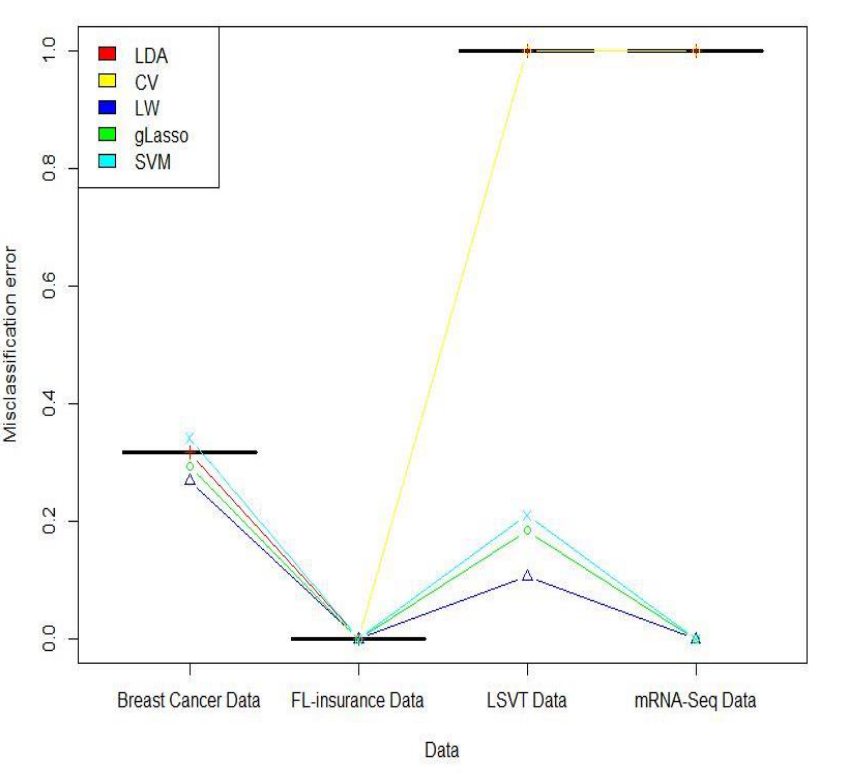
Figure 3. Misclassification error for the four real